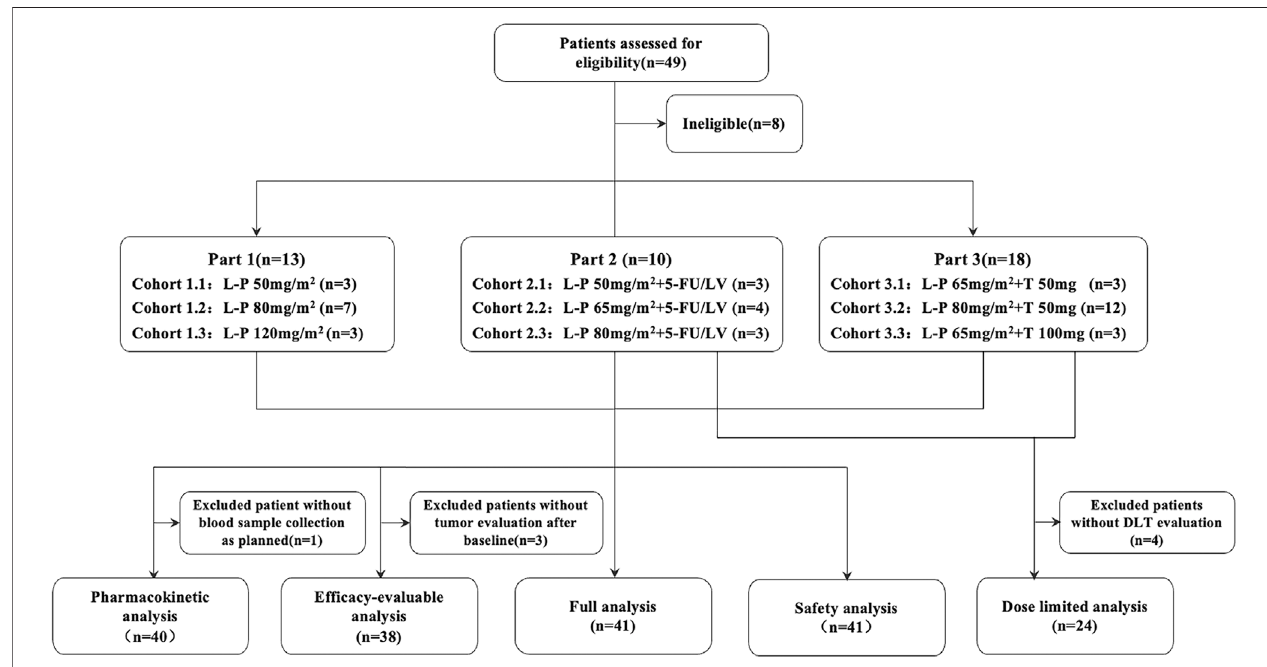
FIGURE 1 | Study pro fi le. The MTD of simmitecan single agent was 120 mg/m 2 every 2 weeks (Q2W), and the recommended dose for expansion was 80 mg/m 2 Q2W based on the results of phase Ia study. Simmitecan 50 mg/m 2 Q2W was the selected starting dose in the single agent and combined dose escalation study, whereassimmitecan80 mg/m 2 Q2Wwastheexpectedhighestdoseincombinationwith5-FU/LVorthalidomideinthisstudy.InPart2,thefollowingdoseofsimmitecan wasdecidedtobe65 mg/m 2 or80 mg/m 2 ,witha fi xeddoseof5-FU/LV(LV400 mg/m 2 ,5-FUbolusat400 mg/m 2 and5-FUcontinuousinfusionat2,400 mg/m 2 , Q2W), where there was a patient who should have received 80 mg/m 2 of simmitecan and mistakenly received 65 mg/m 2 , and this case was not removed from the full analysis set after expert data review. In Part 3, the expansion – dose was determined to be simmitecan 80 mg/m 2 in combination with thalidomide 50 mg. L-P,